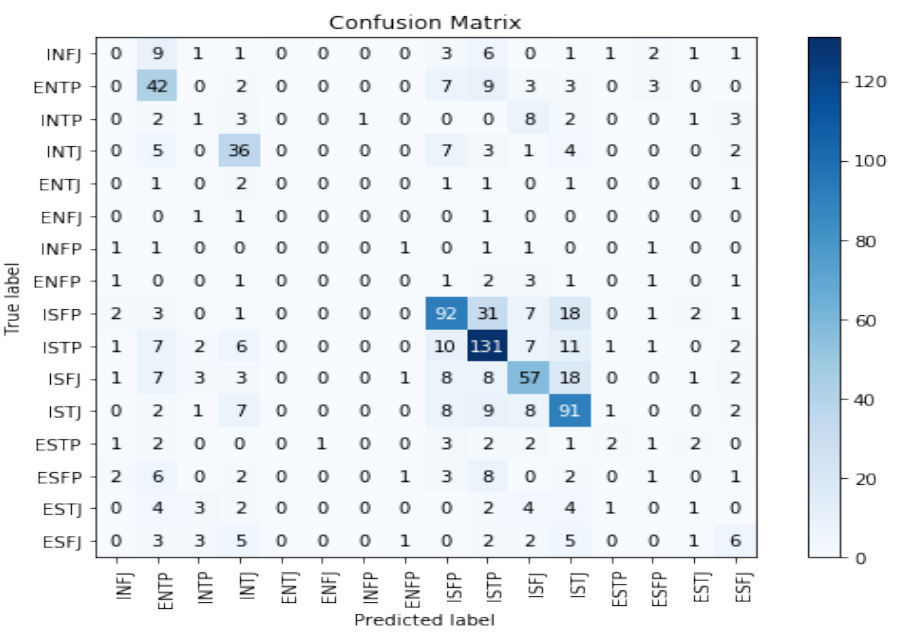
Figure 9. Correctly classified personality type.